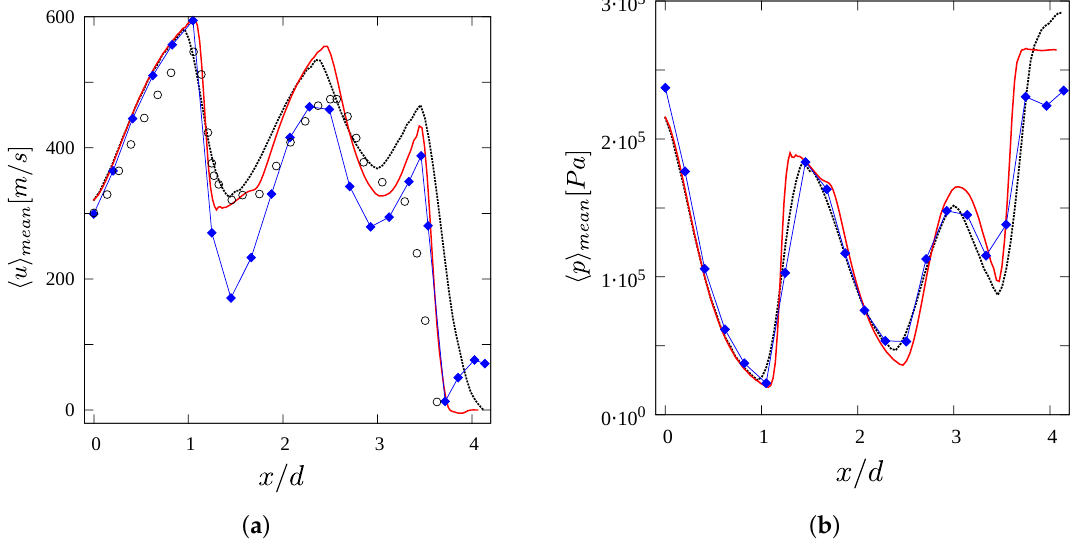
Figure 11. Mean axial velocity and pressure along centerline of impinging jet. Coarse grid ( black curve ); fine grid ( red ), experiment of Henderson et al. [34] ( black circles ), and simulation of Dauptain et al. [35] (blue curve with filled symbol). ( a ) Velocity; and ( b )